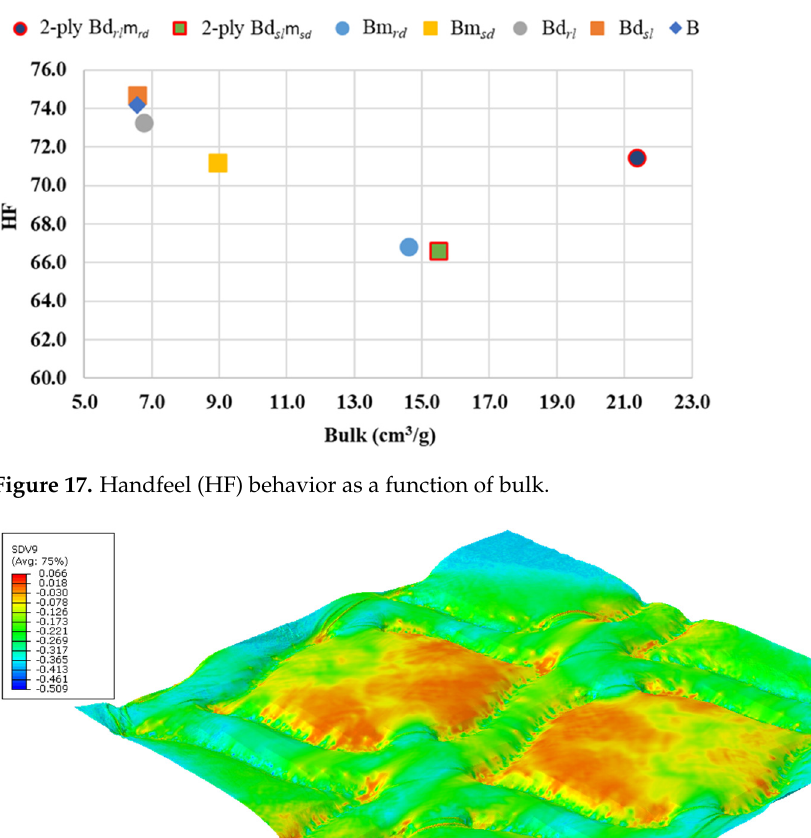
Figure 17. Handfeel (HF) behavior as a function of bulk.